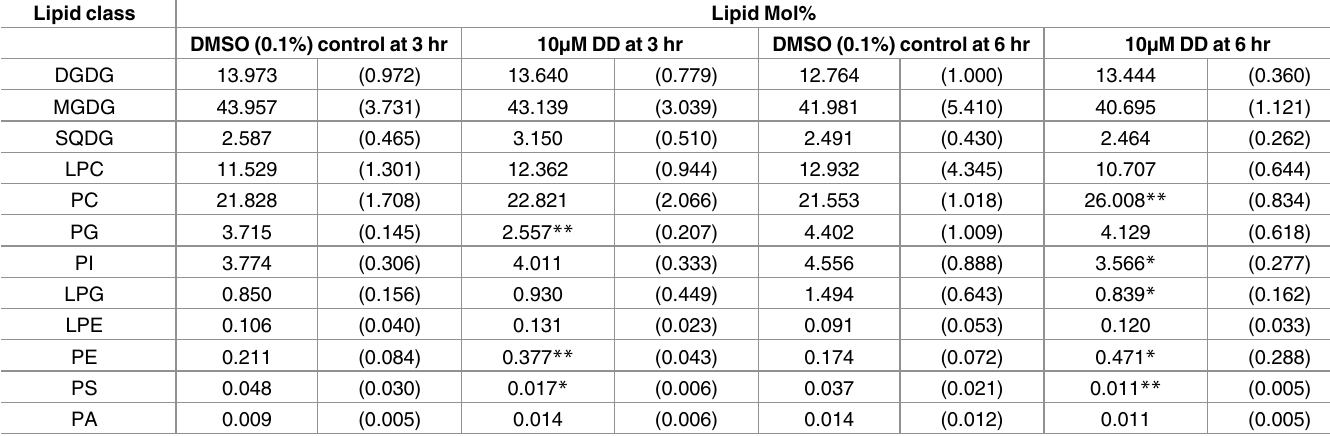
Table 3. Mol % of lipid in each head group class in DMSO solvent and 10 µ M DD treated cells at 3 hr and 6 hr. Data representaverageof 5 biological replicatesfor DMSO and DD treated cells andnumbersin bracket represent standarddeviations; ** p < 0.05, * p < 0.1as determinedby student’st-test compar- ing to the